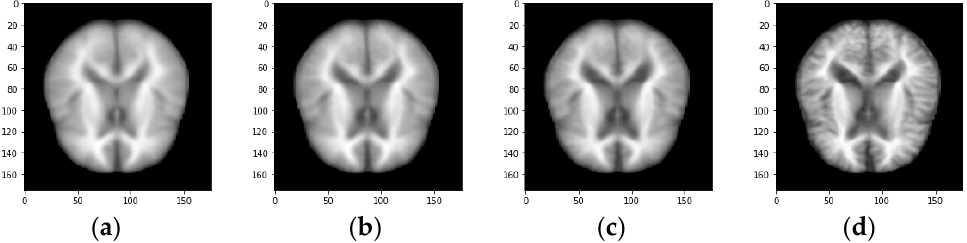
Figure 3. Sample MRI image demented categories. ( a ) Non-demented image ( b ) Very mild demented image ( c ) Mild demented ( d ) Moderate demented.